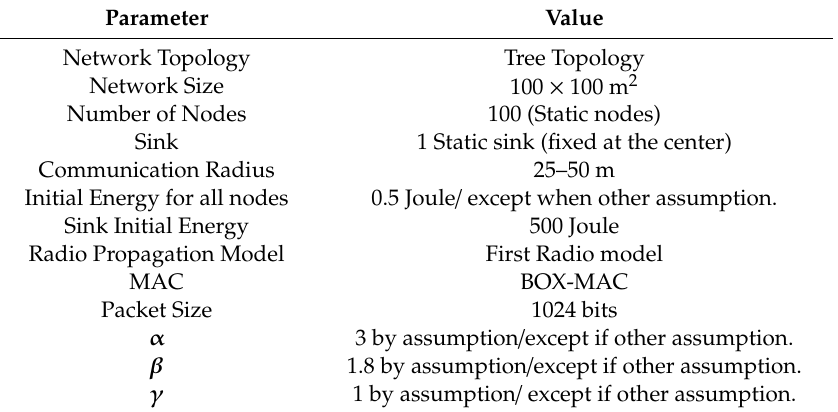
Table 2. Parameters values.